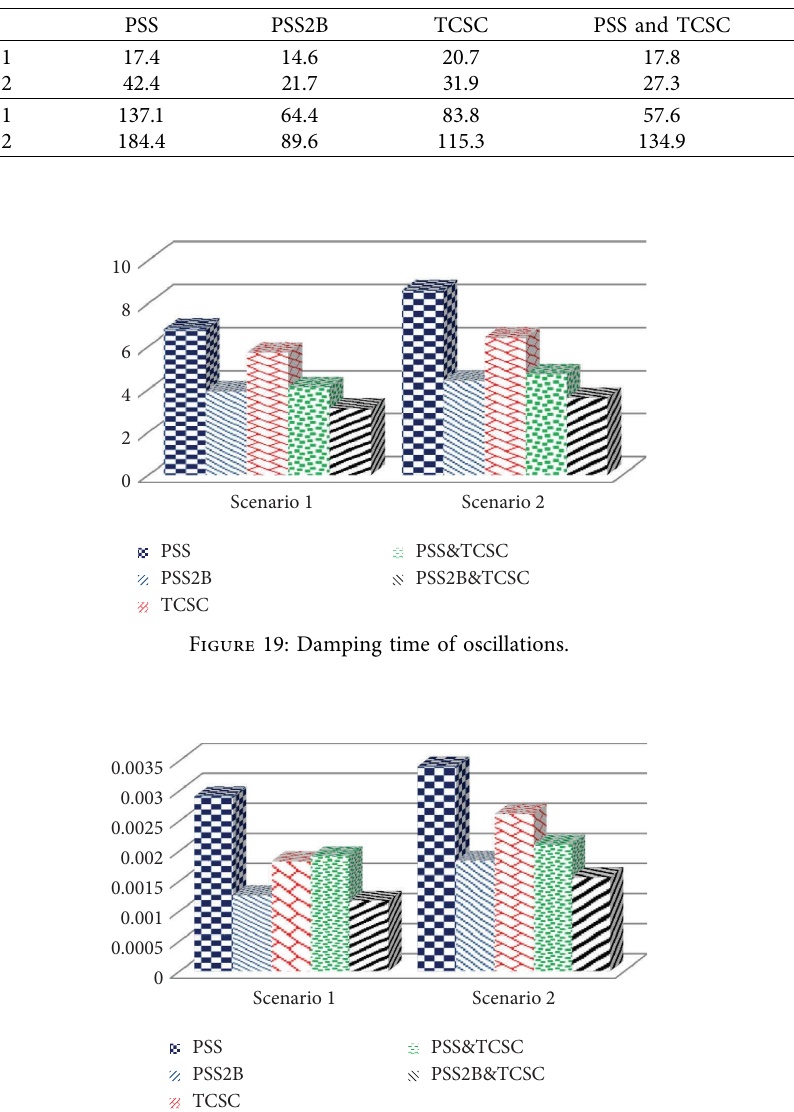
Figure 20: Maximum deviation from the reference